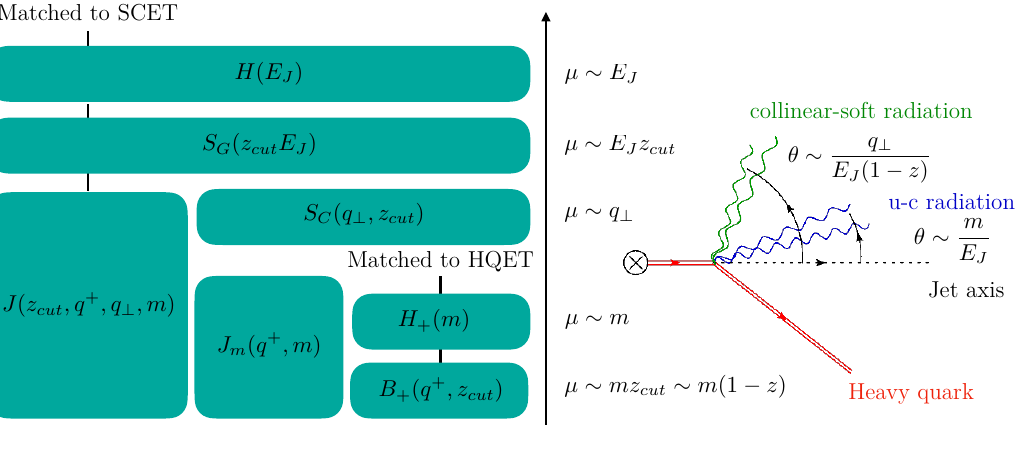
m (1 z )). We now have an Collinear- (cid:0) ? (cid:29) measurements, while the u-c mode only contributes to ?